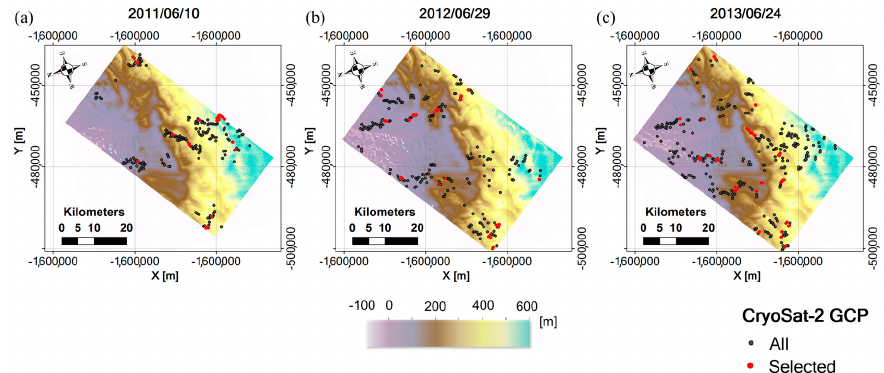
Figure 3. Generated high ‐ resolution surface topography maps of the Thwaites ice shelf on ( a ) 10 June 2011; ( b ) 29 June 2012; and ( c ) 24 June 2013. Dark grey areas denote the locations of all the available CryoSat ‐ 2 SARIn altimeter elevation data, and red circles denote selected data.